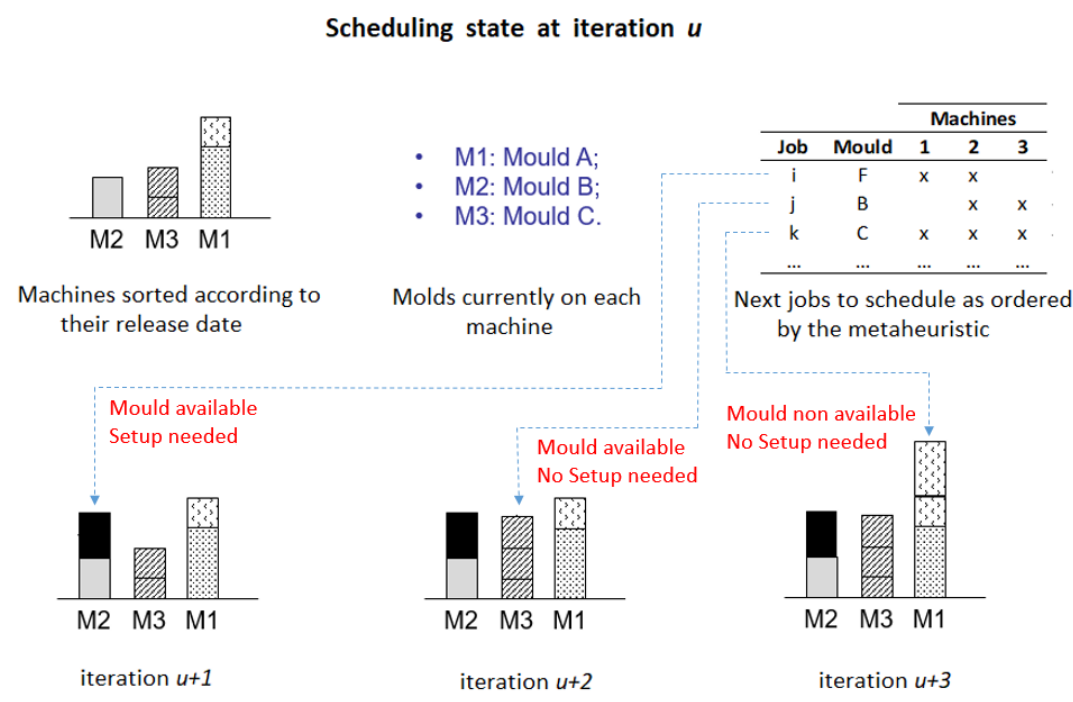
Figure 2. Illustration of the List Algorithm’s assignment